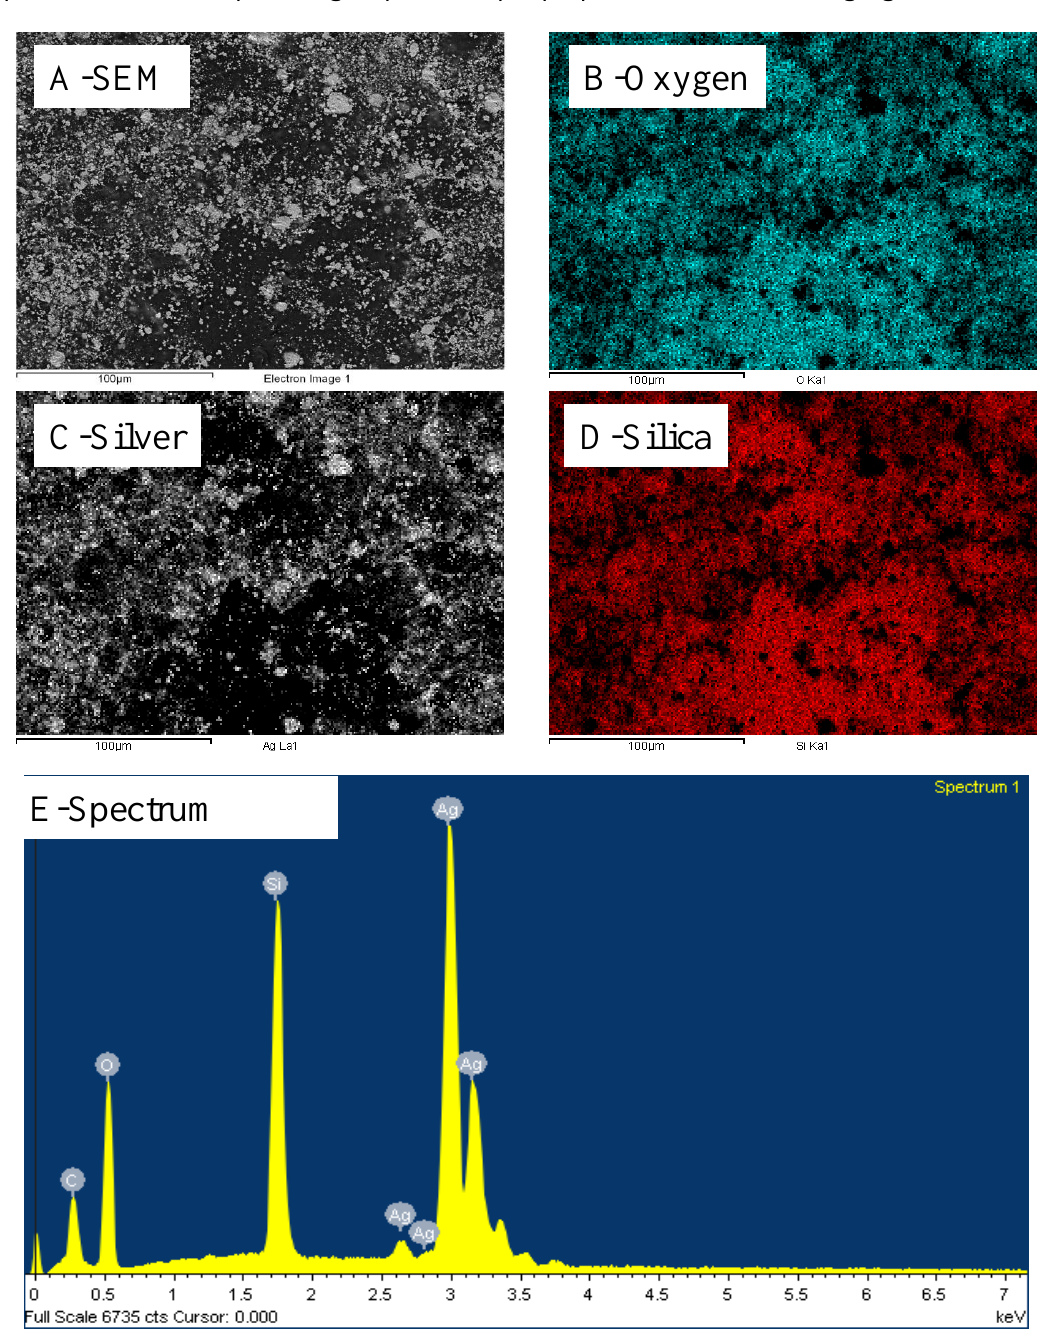
Figure 3. Representative EDS distributions of Si, Ag and O elements across a 10 wt% silica content cold-pressed composite before silica etching presented in Figure 1—carbon is present due to the sputtering step for sample preparation for SEM